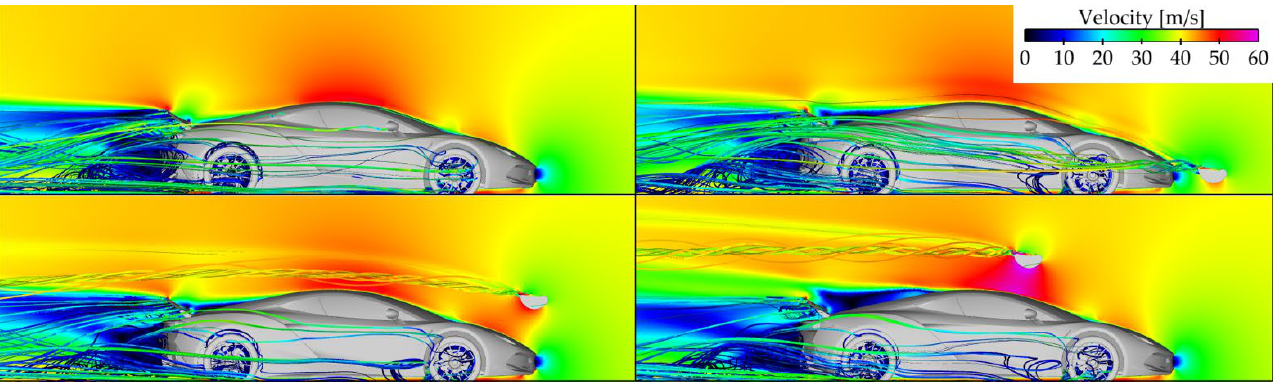
Figure 30. Velocity contours and streamlines around a vehicle without a front wing and for a vehicle with three different wing positions (side view).